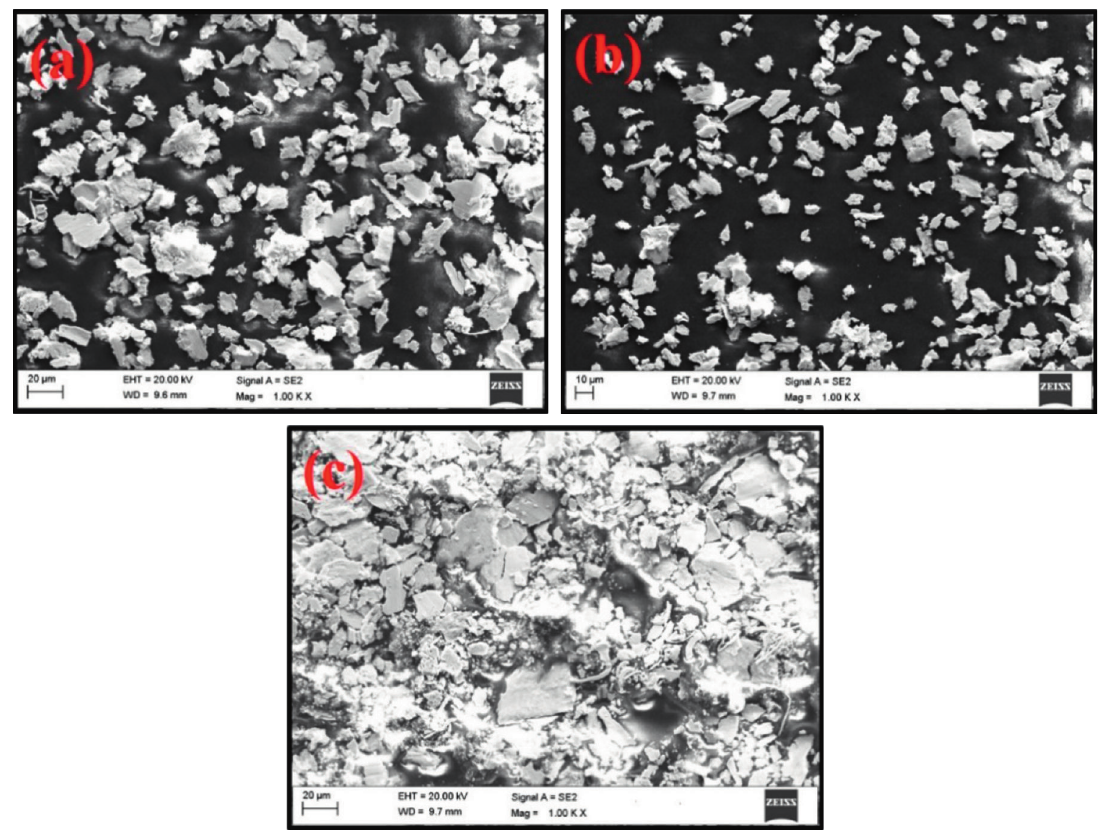
Figure 20: FESEM images of the wear debris collected for (a) 1000rpm, (b) 1200rpm, and (c)